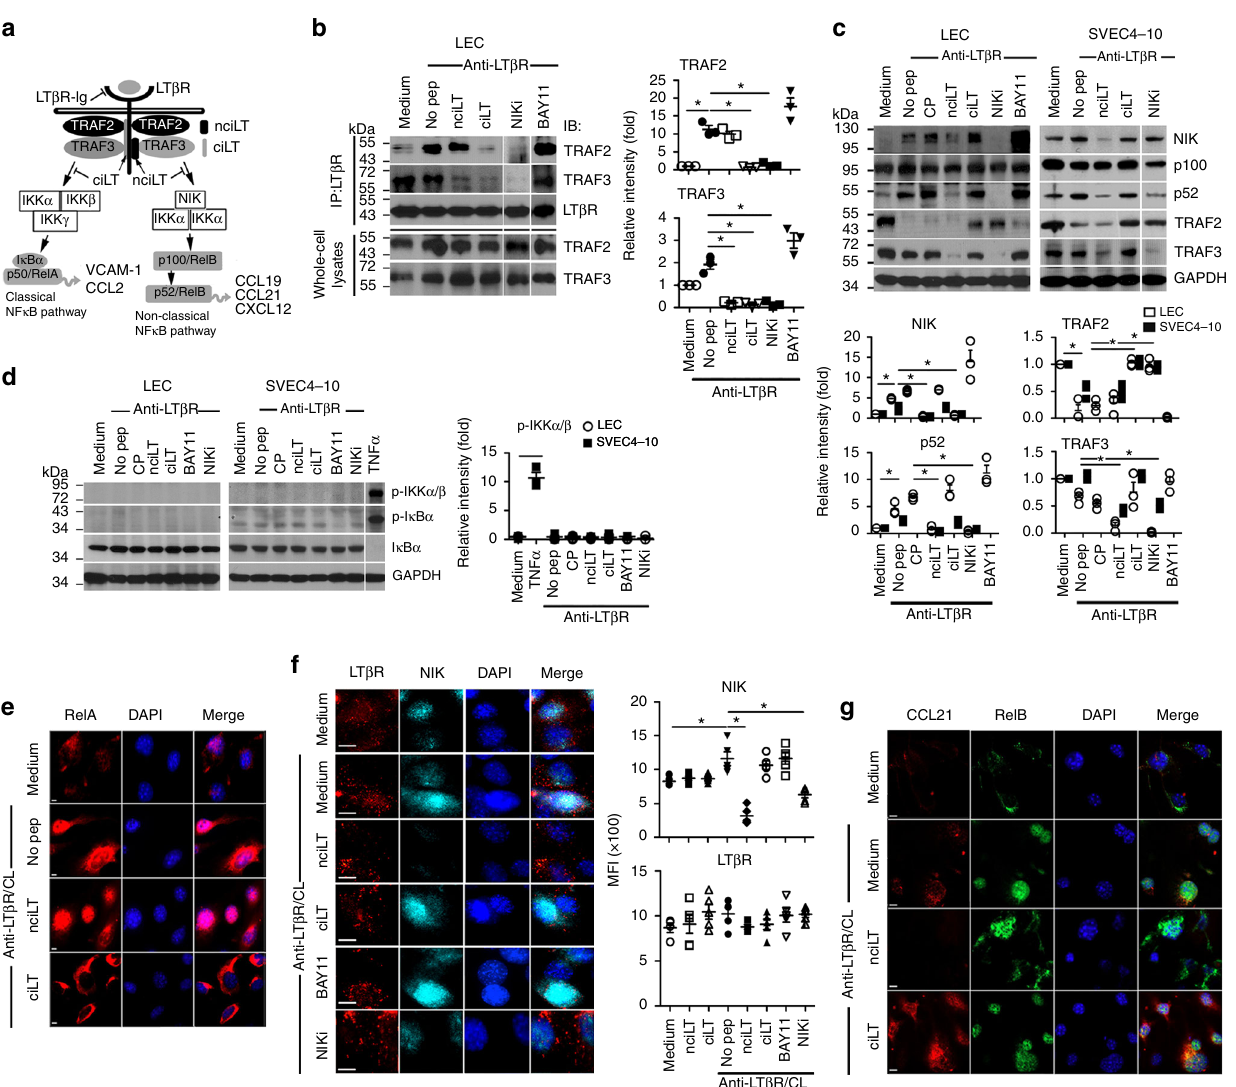
Fig. 3 Targeting of LT β R-mediated classical and non-classical NF κ B signaling pathways by LT β R-speci fi c peptides. a Diagram of peptide selective blockade of separate arms of LT β R signaling. b Immunoprecipitation of LT β R complex with anti-LT β R in lysates of LEC pretreated with the indicated peptides (20 μ M) and then stimulated with anti-LT β R mAb (2 μ g/mL) for 10 min. Complexes run on SDS-PAGE, and immune blotted with anti-TRAF2, anti-TRAF3, and anti-LT β R. c , d LEC and SVEC4-10 pretreated with indicated peptides (20 μ M) or inhibitors (25 μ M BAY11-7085; 50 μ M NIKi) and then stimulated with anti-LT β R (2 μ g/mL) for 6 h ( c ) or 10 min ( d ). In panel d , SVEC4-10 stimulated with 20 ng/mL TNFa. Cell lysates immune blotted for p100, p52, NIK, TRAF2, and TRAF3 ( c ); for IKK α / β , and for I κ B α phosphorylation and degradation ( d ). e Cells treated as in ( d ); immunohistochemistry of RelA. Magni fi cation ×60; scale bar 4 μ m. f , g Cells treated as in ( c ). Immunohistochemistry of LT β R and NIK in SVEC4-10 ( f ); CCL21 and RelB in LEC ( g ). Magni fi cation ×60; scale bar 8 μ m ( f ) or 4 μ m ( g ). The bar graphs in ( b – d ) represent the relative band intensities (mean ± SEM) from three independent experiments. * p < 0.05 by one-way